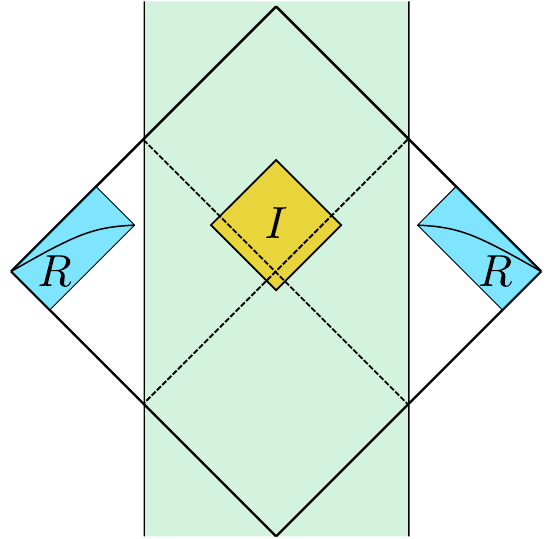
Figure 4 . A two-sided black hole in JT gravity coupled to two bath regions [19]. When we compute the entropy of a large region R in the bath, depending on the parameters, we can have an island I in the gravity region. At sufficiently late times t > 0 there will always be an island.